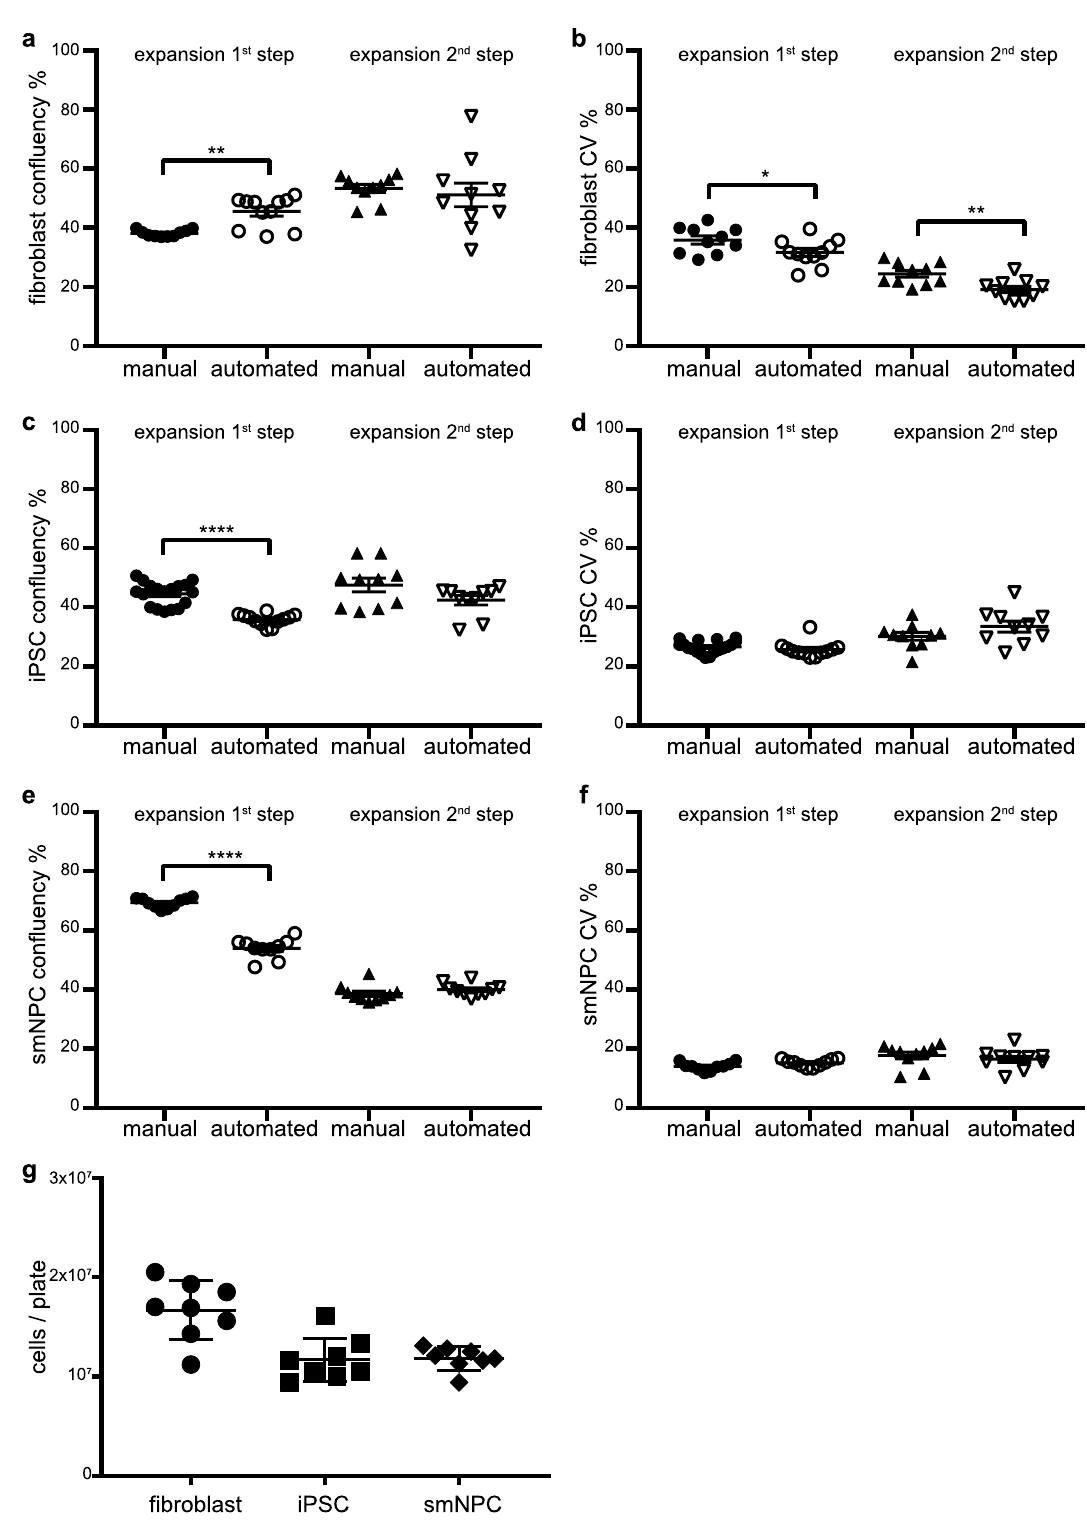
Figure 4. Automated cell culture expansion. ( a ) Confluency of fibroblasts 24 h post splitting for 1st and 2nd expansion step. n = 10, 1st step = Mann–Whitney test; 2nd step = two-tailed t-test. ( b ) CV of fibroblast plates from ( a ). two-tailed t-test. ( c ) Confluency of iPSC 24 h post splitting for 1st (n = 12) and 2nd (n = 10) expansion step. 1st step = two-tailed t-test; 2nd step = Mann–Whitney test. ( d ) CV of iPSC plates from ( c ). 1st step = Mann– Whitney test, 2nd step = two-tailed t-test. ( e ) Confluency of smNPC 24 h post splitting for 1st and 2nd expansion step . n = 10, two-tailed t-test. ( f ) CV of smNPC plates from ( e ). n = 10, 1st step = Mann–Whitney test; 2nd step = two-tailed t-test. ( g ) Number of cells counted from confluent 1-well plates. n = 8. *p < 0.05, **p < 0.01, ****p <